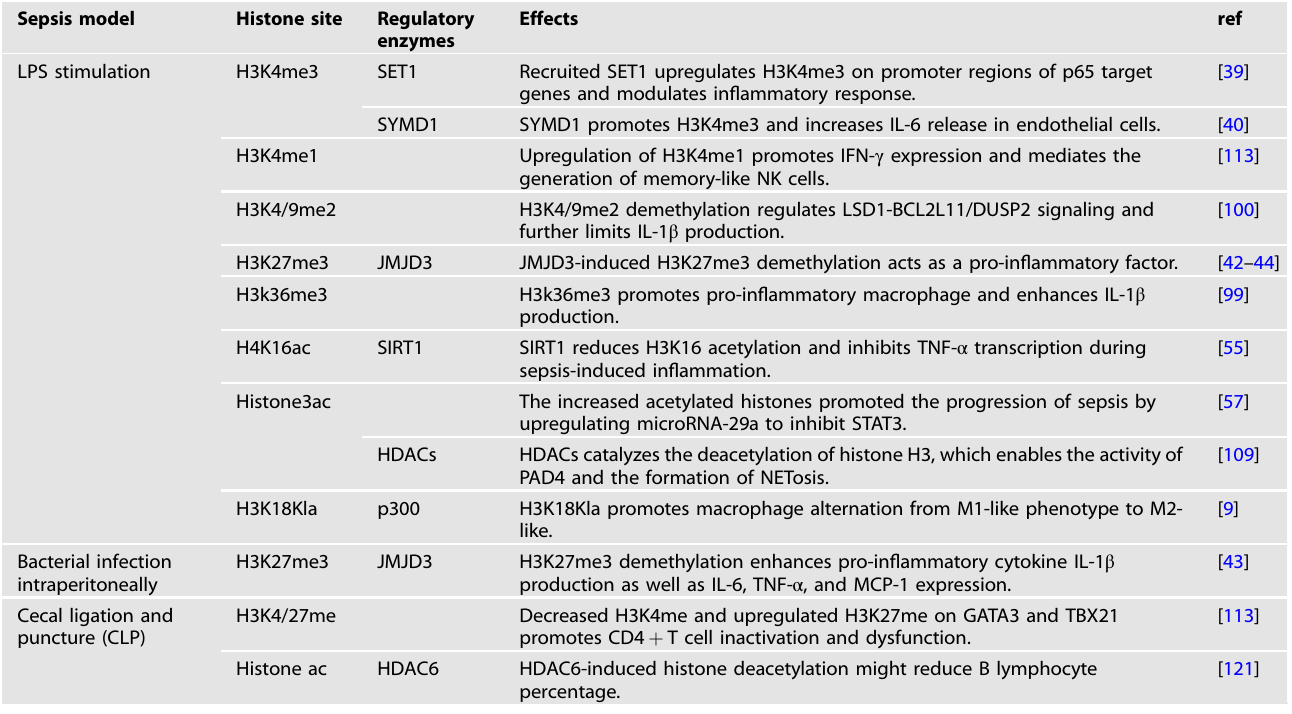
Table 2. Differences of histone modi fi cation between different methods induced